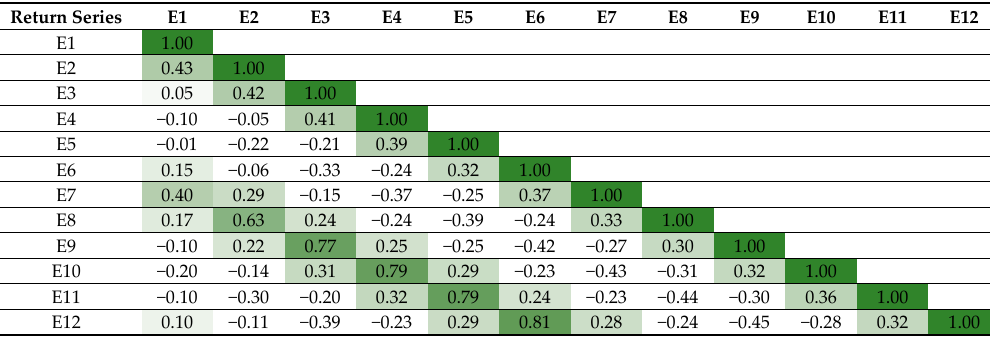
Table 5. Correlation coe ffi cients between electricity futures.